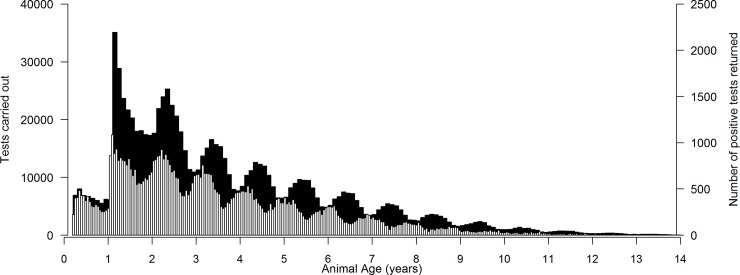
Distribution by animal age (in years) of the total number of tests carried out (primary axis; filled) and the number of positive results returned (secondary axis; no fill) during bovine tuberculosis-breakdowns.